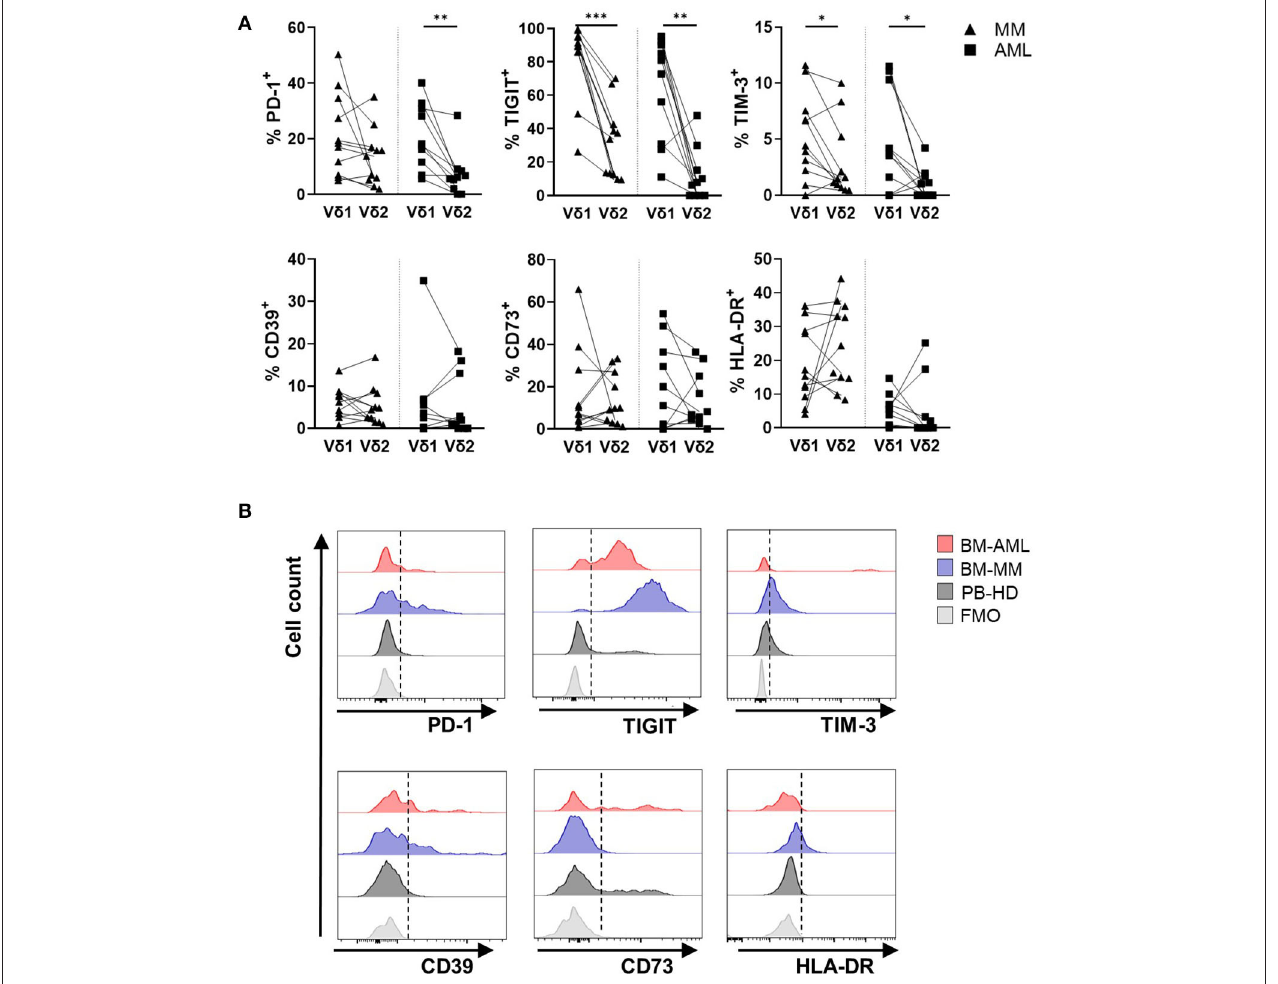
FIGURE 4 | V δ 1 γδ T cells highly express PD-1, TIGIT, TIM-3, but not CD39, CD73, and HLA-DR in AML and MM. The surface expression of PD-1, TIGIT, TIM-3, CD39, CD73, and HLA-DR was compared between V δ 1 and V δ 2T cells in bone marrow (BM) aspirates from patients with multiple myeloma (MM, black triangles, n = 11) and newly diagnosed AML patients (AML, black rectangles, n = 10). (A) Summary data show the paired distribution of PD-1, TIGIT, TIM-3, CD39, CD73, and HLA-DR expression in V δ 1 and V δ 2T cells per patient. P -values were obtained by the Wilcoxon matched-pairs signed-rank test. * P < 0.05, ** P < 0.01, *** P < 0.001. (B) Representative flow cytometry histograms demonstrate the expression of PD-1, TIGIT, TIM-3, CD39, CD73, and HLA-DR on γδ T cells in healthy donors (HD, dark gray), multiple myeloma patients (MM, blue), and newly diagnosed AML patients (AML, red) in comparison to the fluorescence-minus-one control (FMO,